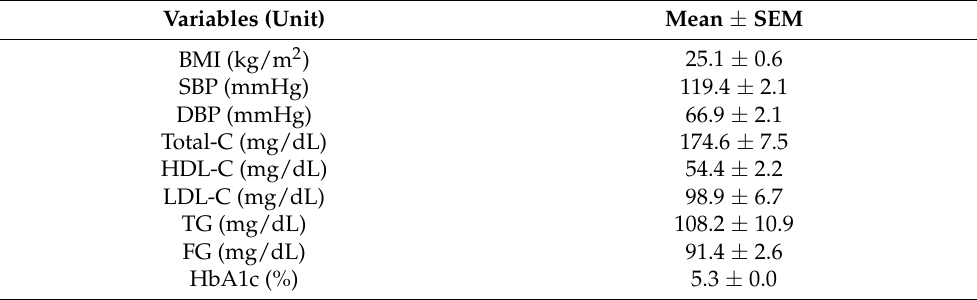
Table 2. Anthropometric parameters and cardiometabolic risk factor of